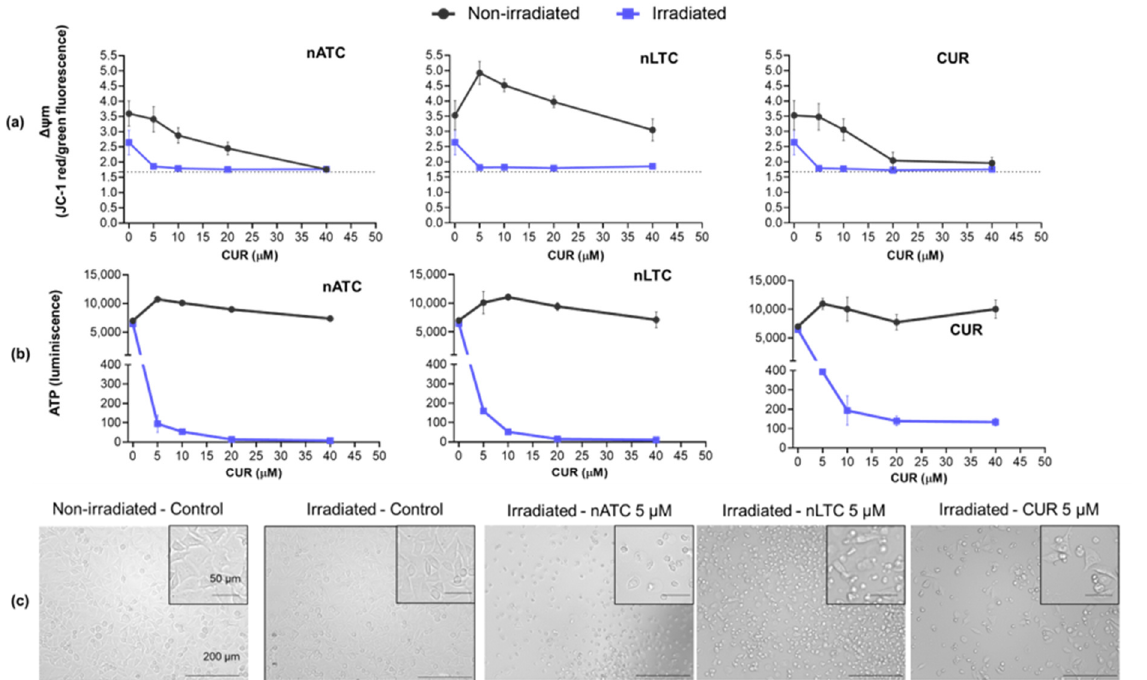
Figure 4. PDT cell damages on A549 cell line. Cells were incubated with nATC, nLTC, or free CUR at 5, 10, 20, and 40 µ M, irradiated with a fluence of 9 J/cm 2 or kept in the dark (non-irradiated). After 24 h, changes in ( a ) mitochondrial membrane potential ( ∆Ψ m) and ( b ) ATP content were measured. ( c ) Bright-field microscopy images of A549 cell line after PDT, with 5 µ M CUR and a fluence of 9 J/cm 2 .